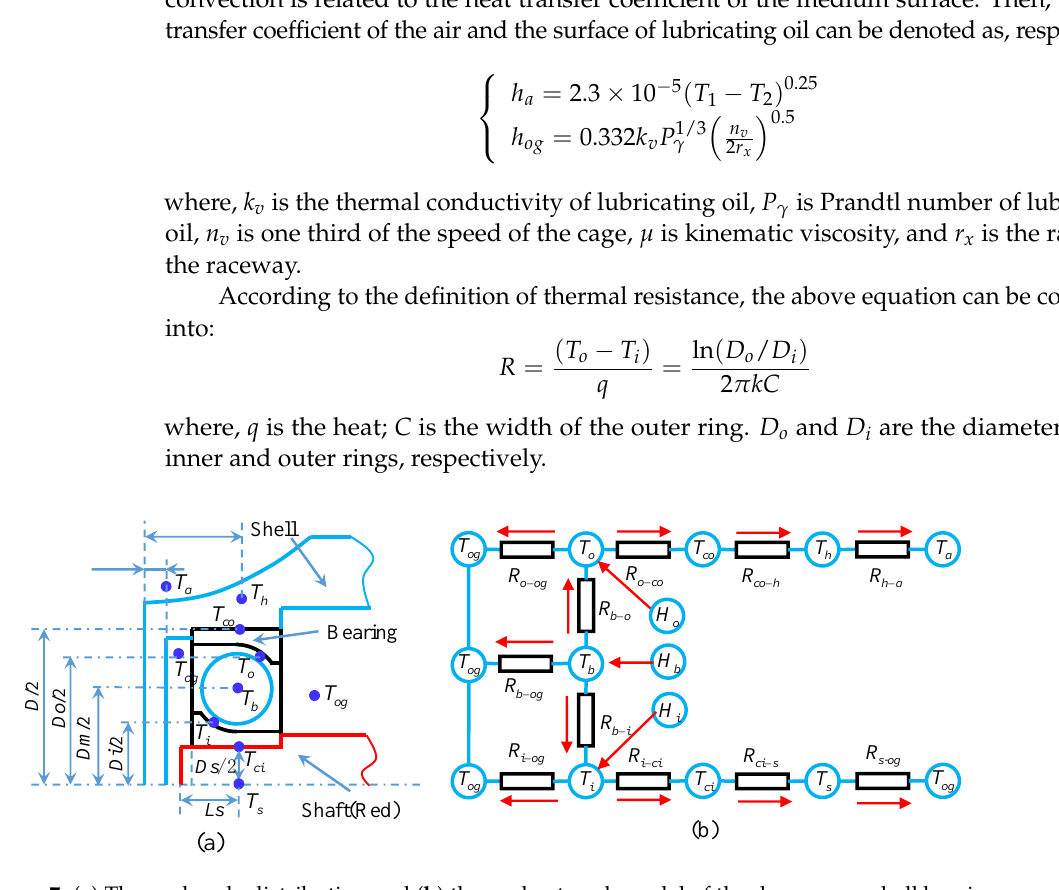
Figure 7. ( a ) Thermal node distribution and ( b ) thermal network model of the deep groove ball bearing. The thermal resistance of each structure in the process of heat transfer is shown